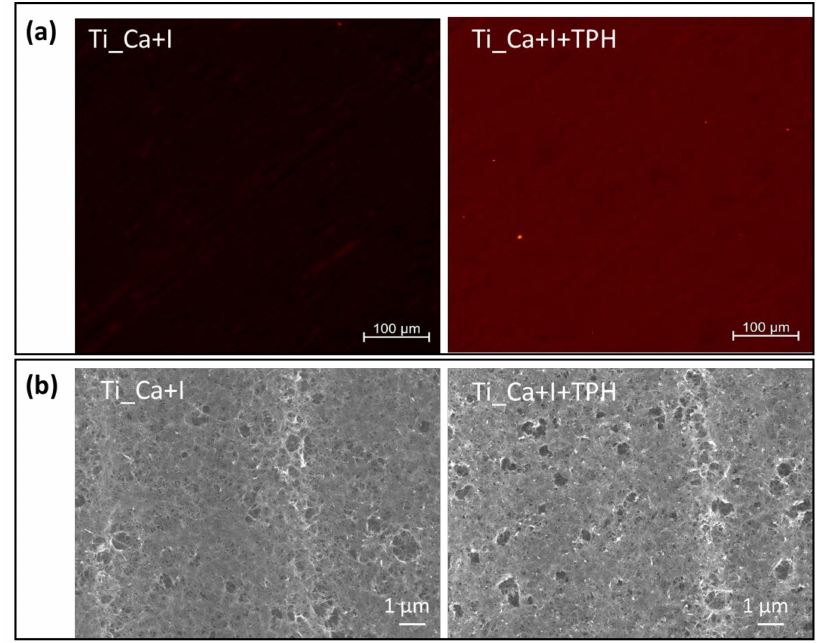
Figure 6. Morphology of Ti_Ca+I and Ti_Ca+I+TPH samples. ( a ) Fluorescence microscopy observa- tions.( b ) Surface FE-SEM